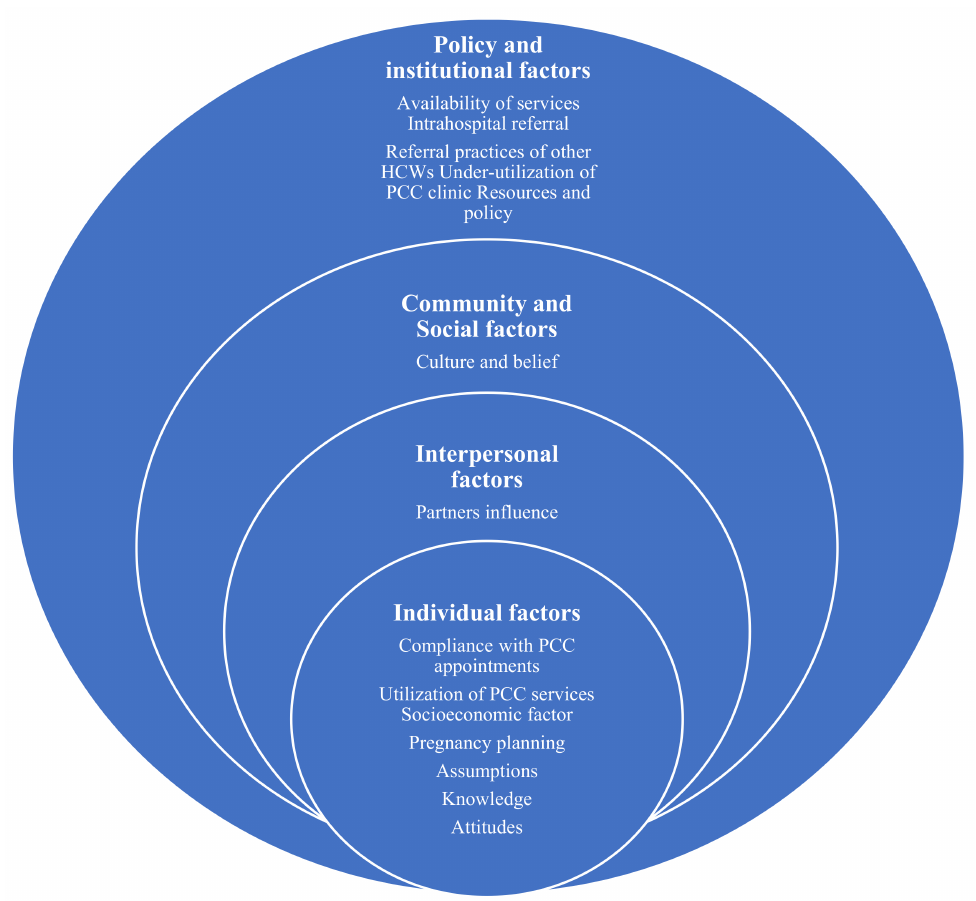
Figure 1. Factors influencing women’s utilization of preconception care based on the adapted Social-Ecological